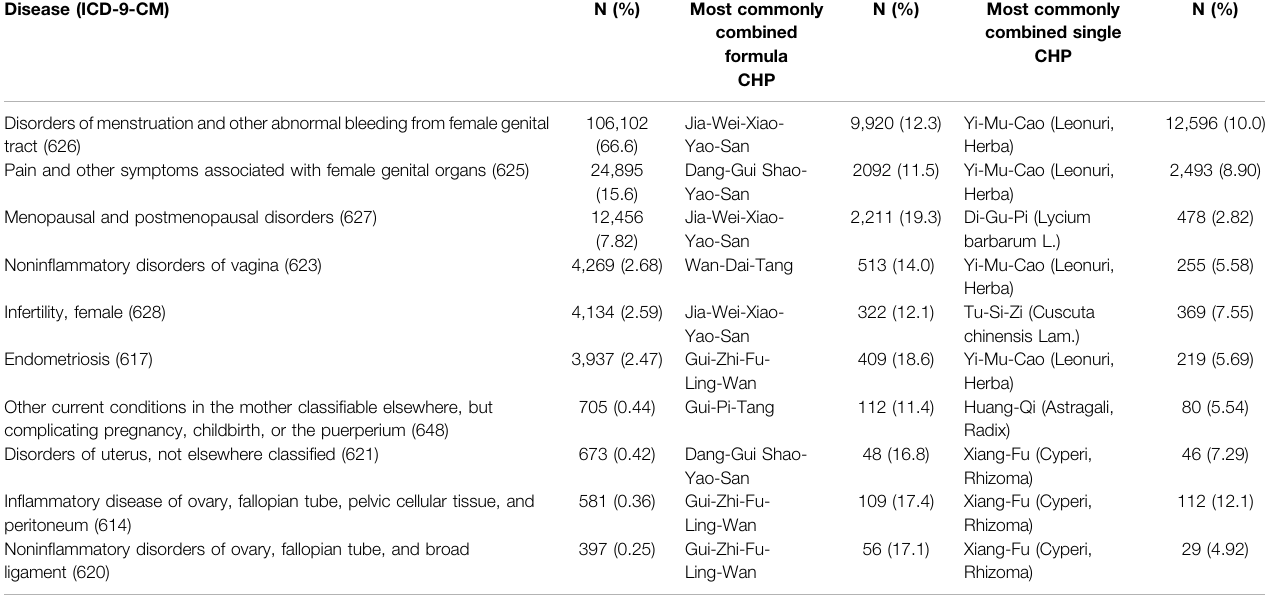
TABLE 6 | Top 10 gyncological diseases (primary code) treated with radix Salvia miltiorrhiza . Disease